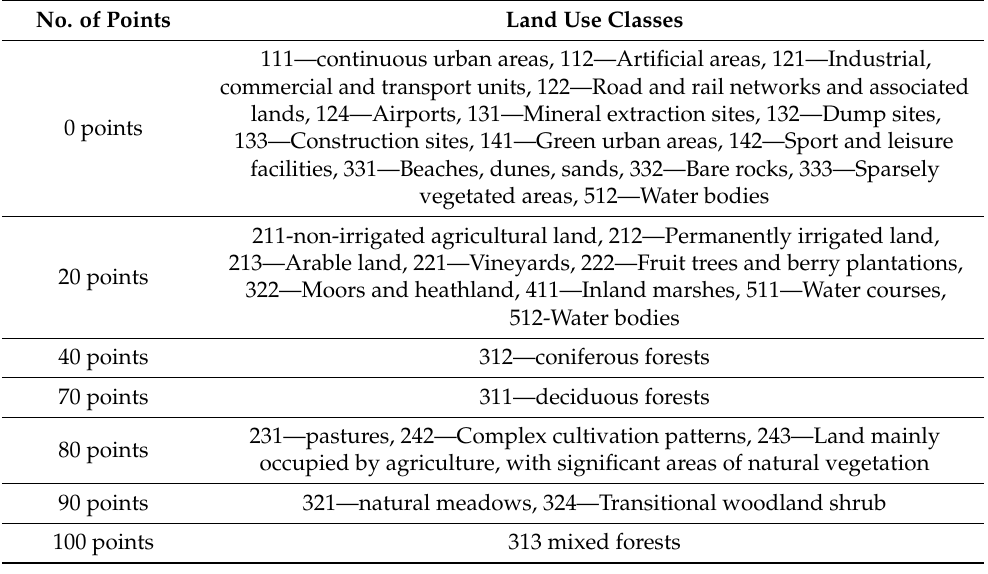
Table 1. Land use classes and their suitability